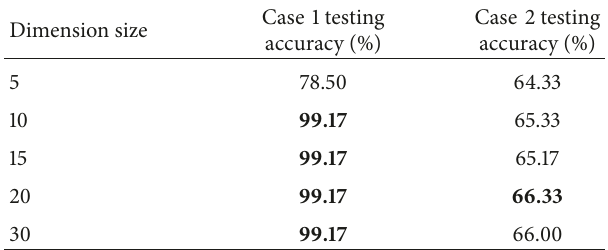
Table 20: Bearing fault diagnosis results obtained by the OFS- FSASD-PCA-SVM (dimension size is 20).